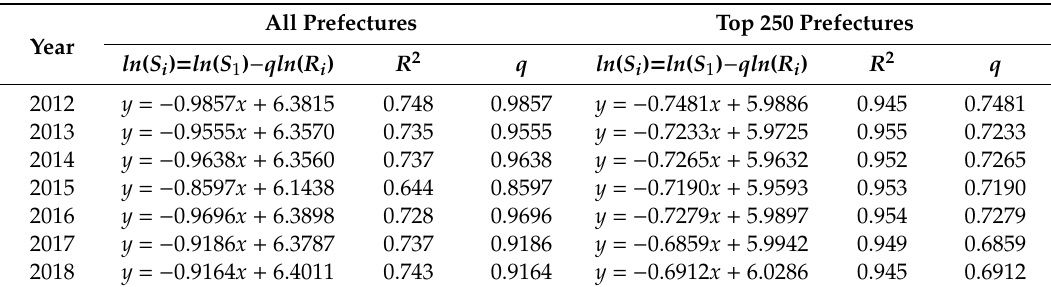
Table 3. The Zipf law analysis at the prefectural level in China from 2012 to